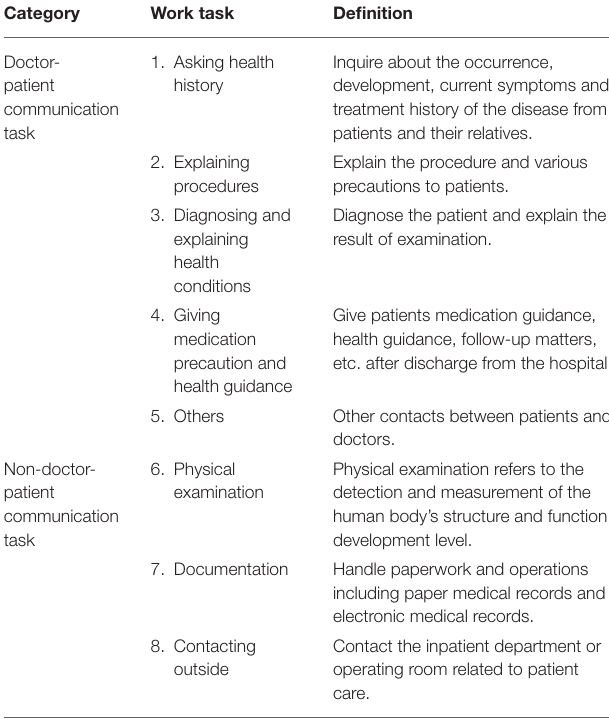
TABLE 1 | Types of work